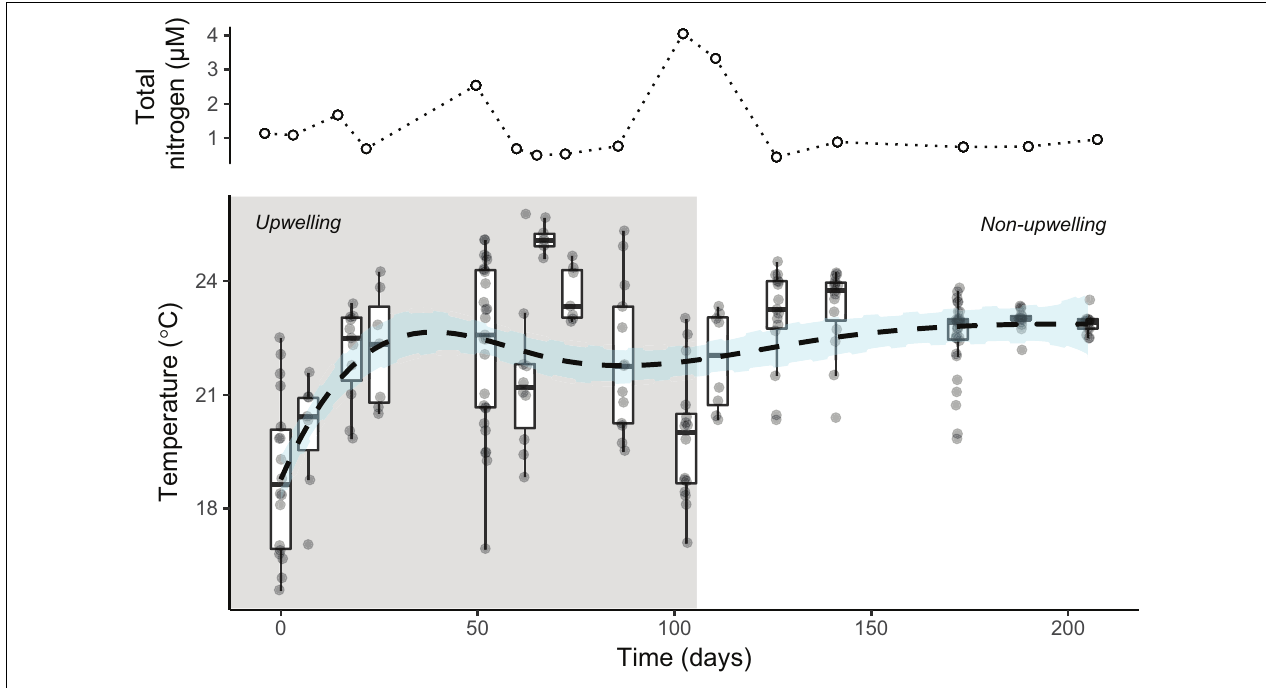
FIGURE 2 | Total nitrogen (NH 4 + , NO 2 − and NO 3 − ) concentration ( µ M) and temperature variation (circles = samples, bar = median, box = 1st/3rd quartiles, and whiskers = 1.5 × interquartile range) during experimental period of herbivore exclusion at Arraial do Cabo (RJ, Brazil). Shaded area indicates the period of higher variation in temperature (upwelling season). The dashed line ( ± SE in light blue) indicated the smoothing spline estimates ( k = 4) of mean temperature values. Values below 20 ◦ C are considered to be from South Atlantic Central Water masses, indicating upwelling events (Valentin,